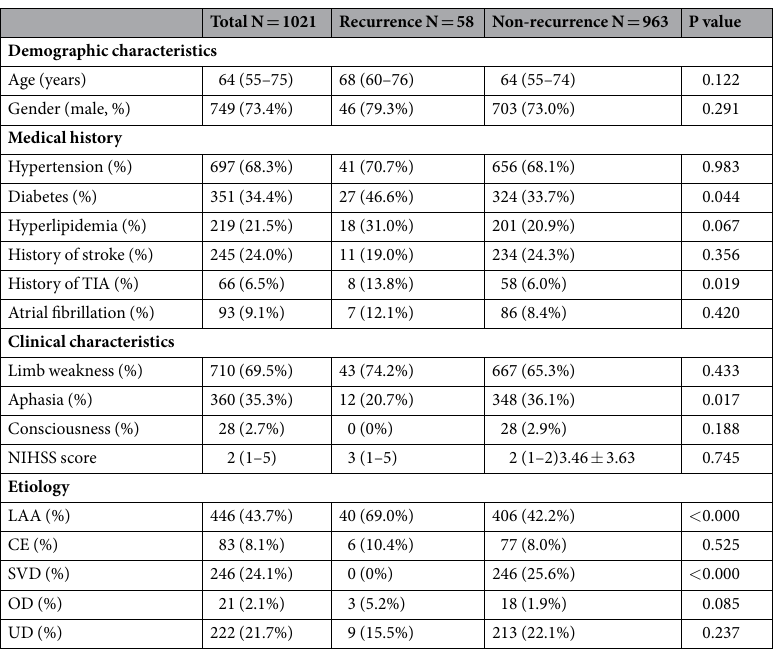
Table 2. Comparison of the baseline characteristics of the patients with and without recurrent stroke.